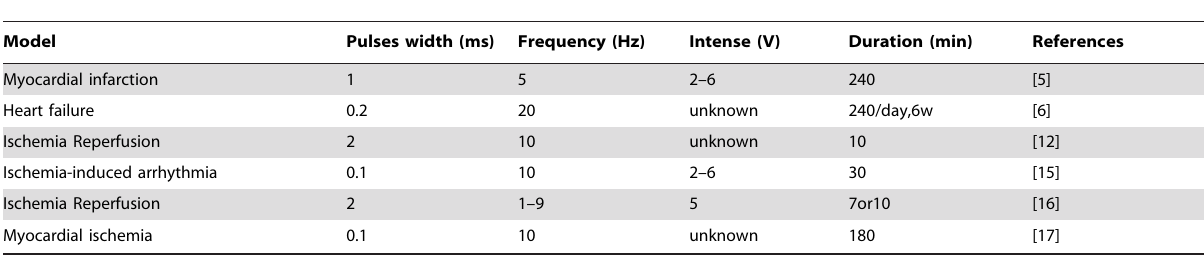
Table 1. Parameters of vagus nerve stimulation on rats with ischemia heart disease.